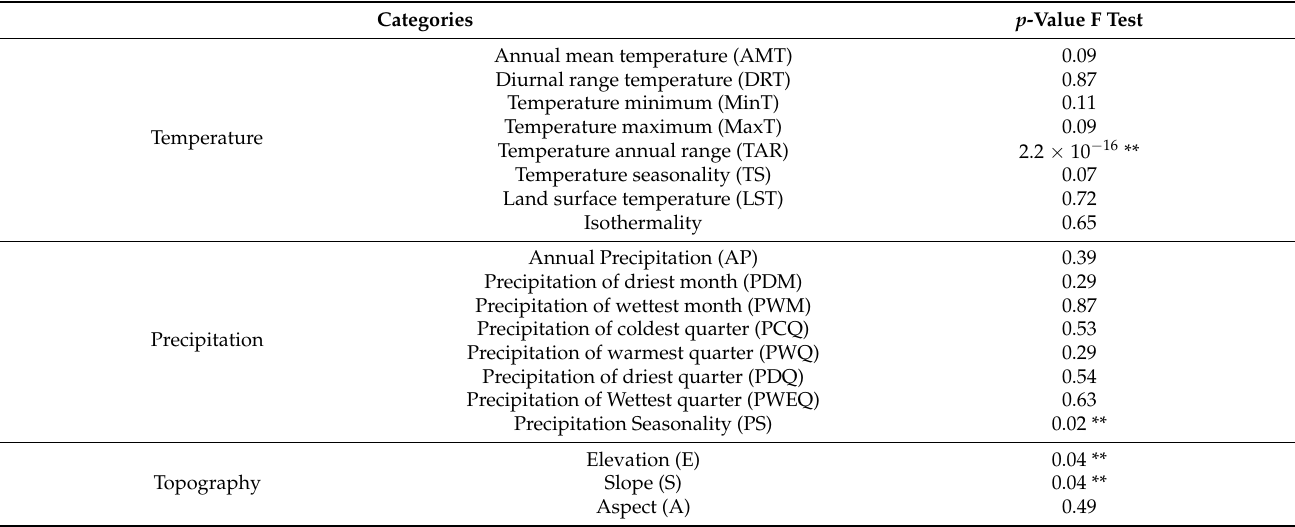
Table 7. F-test results for all habitat characteristic